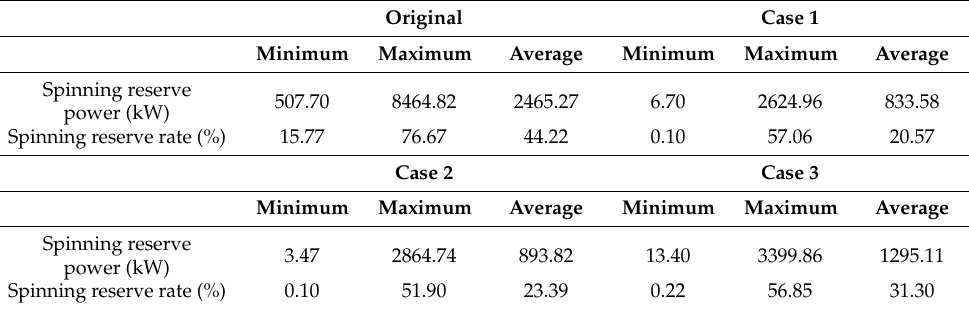
Table 5. Overall results for the spinning reserve power and